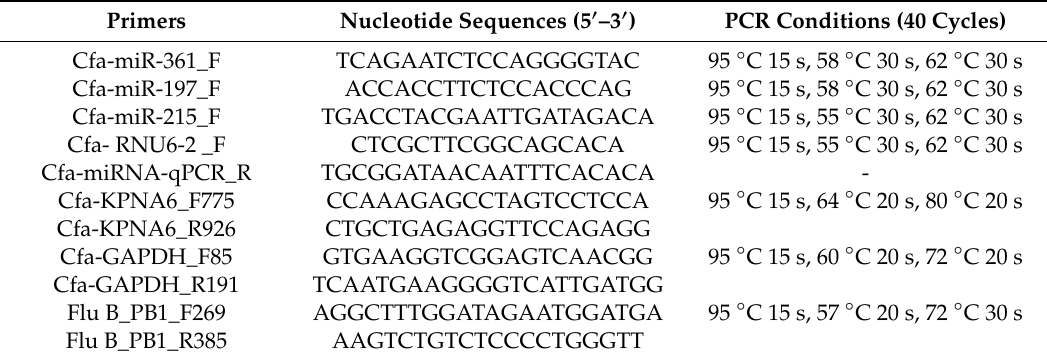
Table 1. Primers and PCR